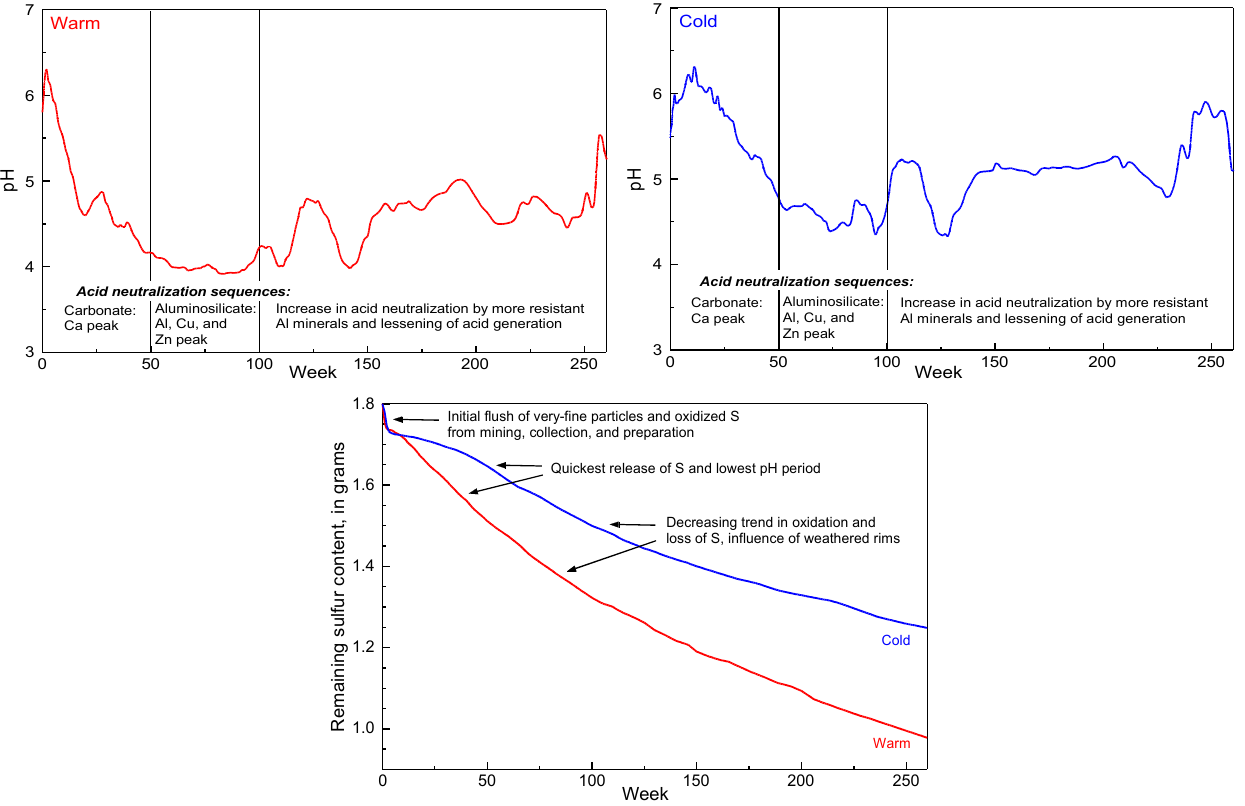
Figure 10. Temporal variation (moving average trendline of a 3-data point window) of the pH of leachate and consumption of sulfide minerals (as S) through weathering and leaching from Type III rock in warm and cold humidity